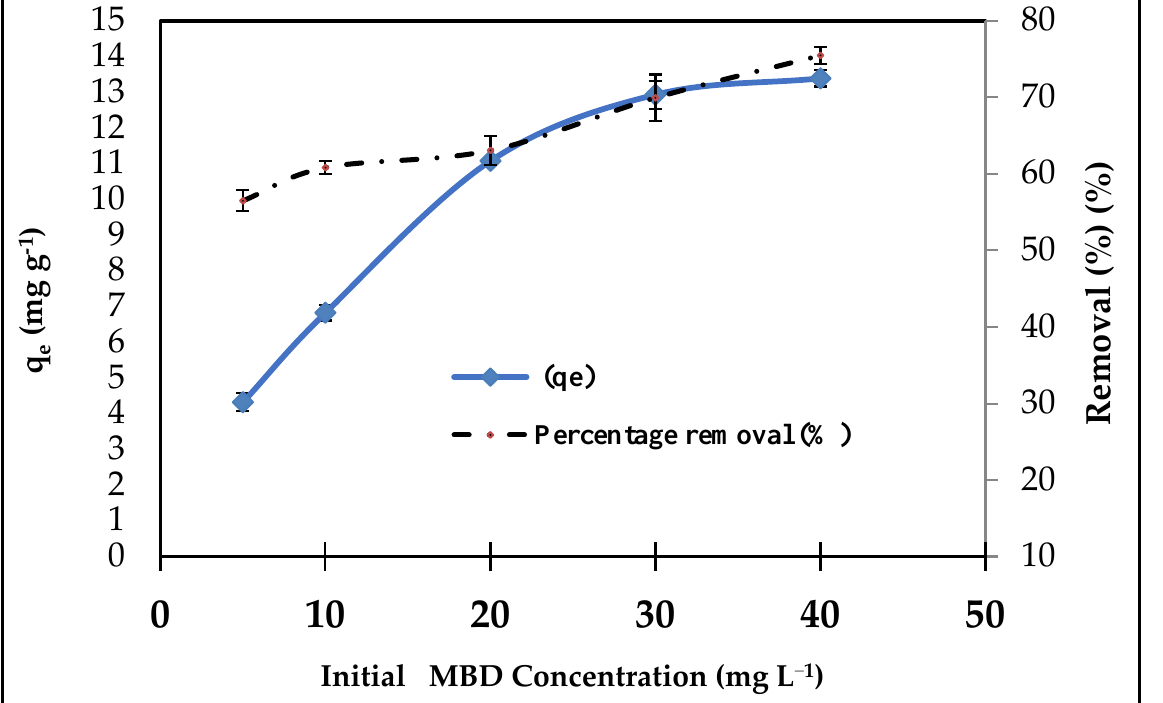
Figure 6. Effect of initial concentration on the percentage removal of MBD onto A. platensis nanoparticles (adsorbent amount: 0.1 g; initial volume: 50 mL; pH: 6; contact time: 180 min; 303 K).